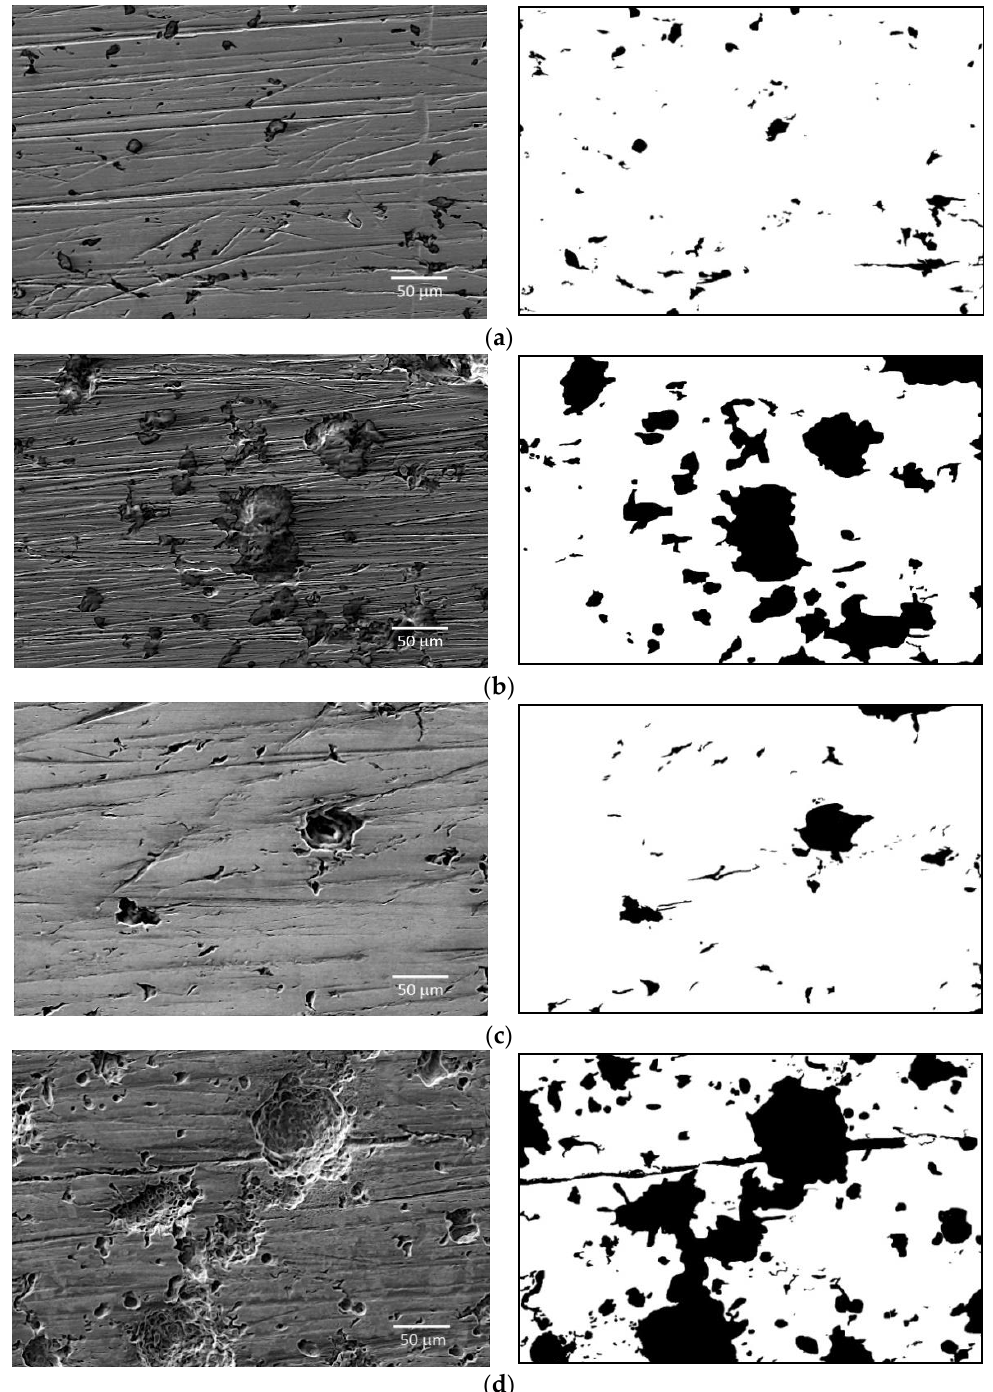
Figure 7. Exemplary SEM image (on the left) with the corresponding conversion to black and white (on the right) for the AISI 1010 carbon steel after the experiment in sulfolane at 95 ◦ C without etching before ( a ) and after ( b ) potentiodynamic test; after the experiment in sulfolane at 95 ◦ C with etching before ( c ) and after ( d ) potentiodynamic test (see Figure 6).